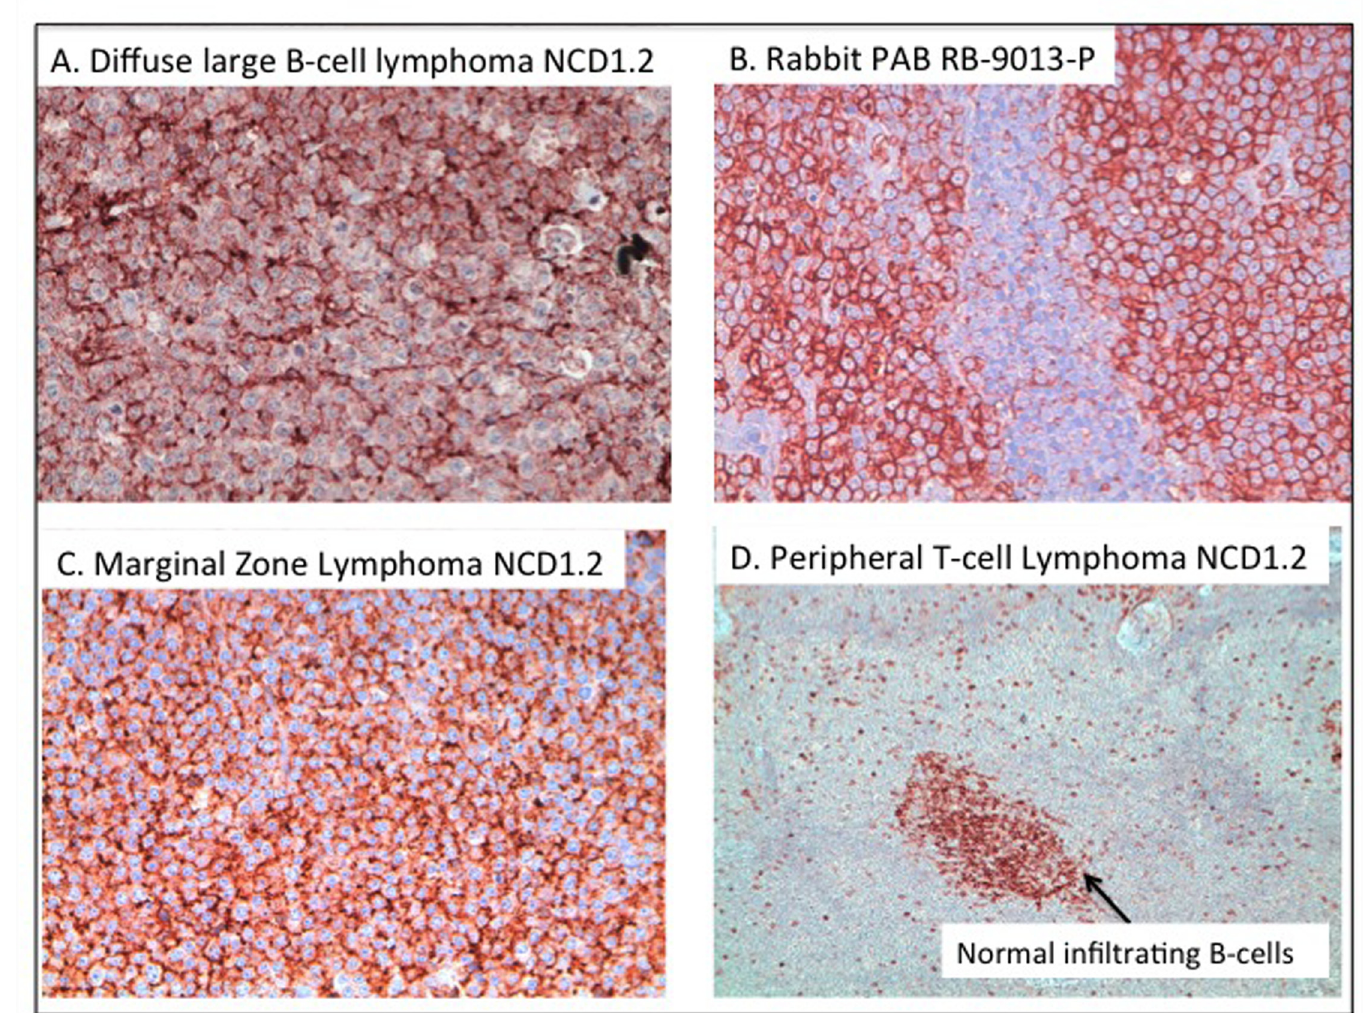
Fig 5. Expression of CD20 protein in formalin fixed paraffin imbedded canine cancer tissue. The indicated formalin-fixed, paraffin-embedded tissues were processed using immunohistochemistry as indicated in the materials and methods; and include representative images: (A) NCD1.2 staining in diffuse large B cell lymphoma (20x); (B) polyclonal anti-cd20 rabbit antibody staining in DLBCL (20x); (C) NCD1.2 staining in marginal zone lymphoma (20x); and (D) lack of NCD1.2 staining in peripheral T-cell lymphoma (10x); with infiltrating normal B-cells that are CD20+ highlighted by the arrow. The staining in brown highlights the position of the NCD1.2 reactive protein with nuclei stained in